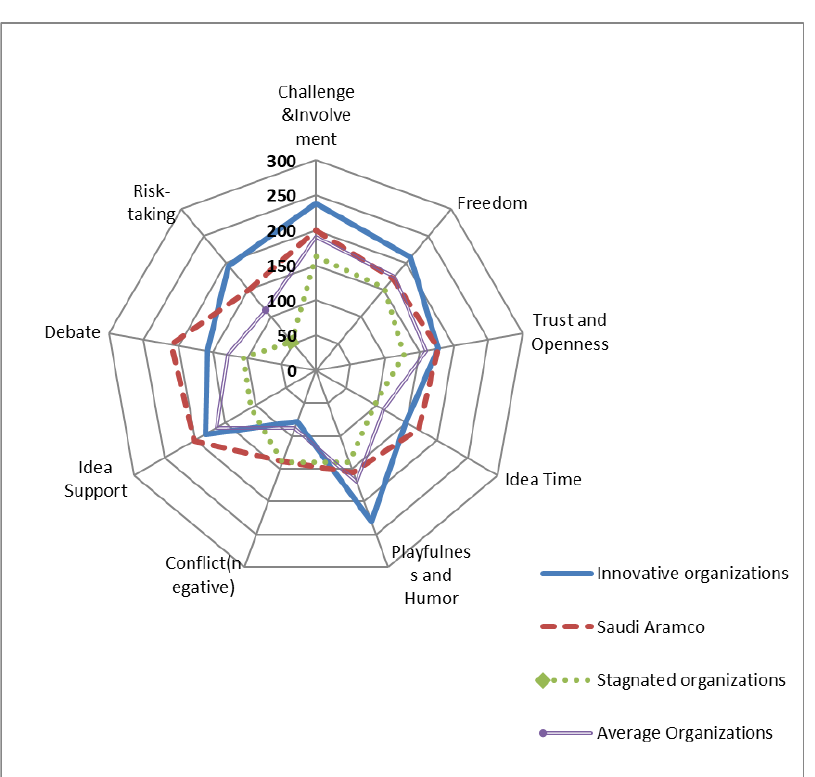
Fig. 3. The company innovation dimensions compared with the innovative, average and stagnated